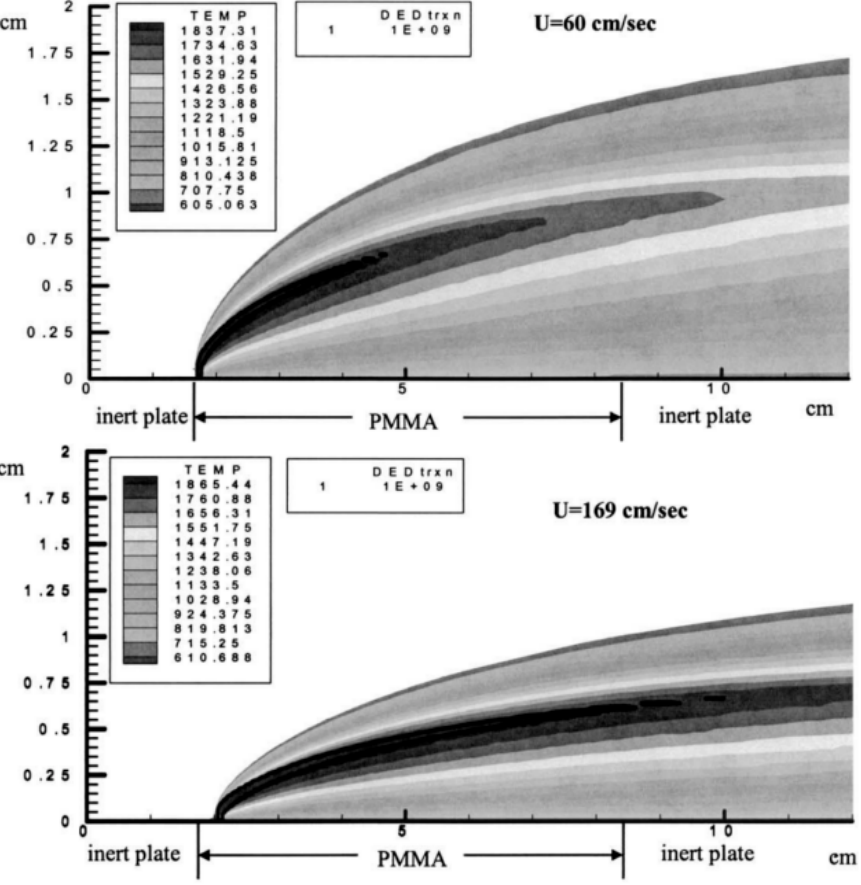
Figure 18. NS solutions for temperature (grayscale) and heat release rate (solid line) contours [128].